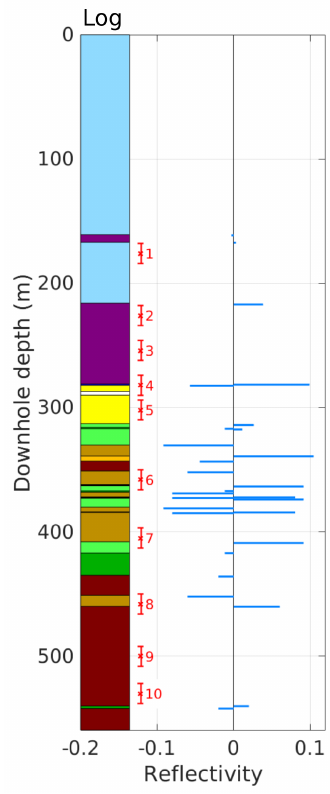
Figure 11. Comparison between the KU-958 borehole log and synthetic reflectivity series derived from petrophysical velocities and densities. Red numbers denote the reflectors picked from the VSP image obtained from borehole KU-941 (Figure 10); error intervals are equal to the dominant